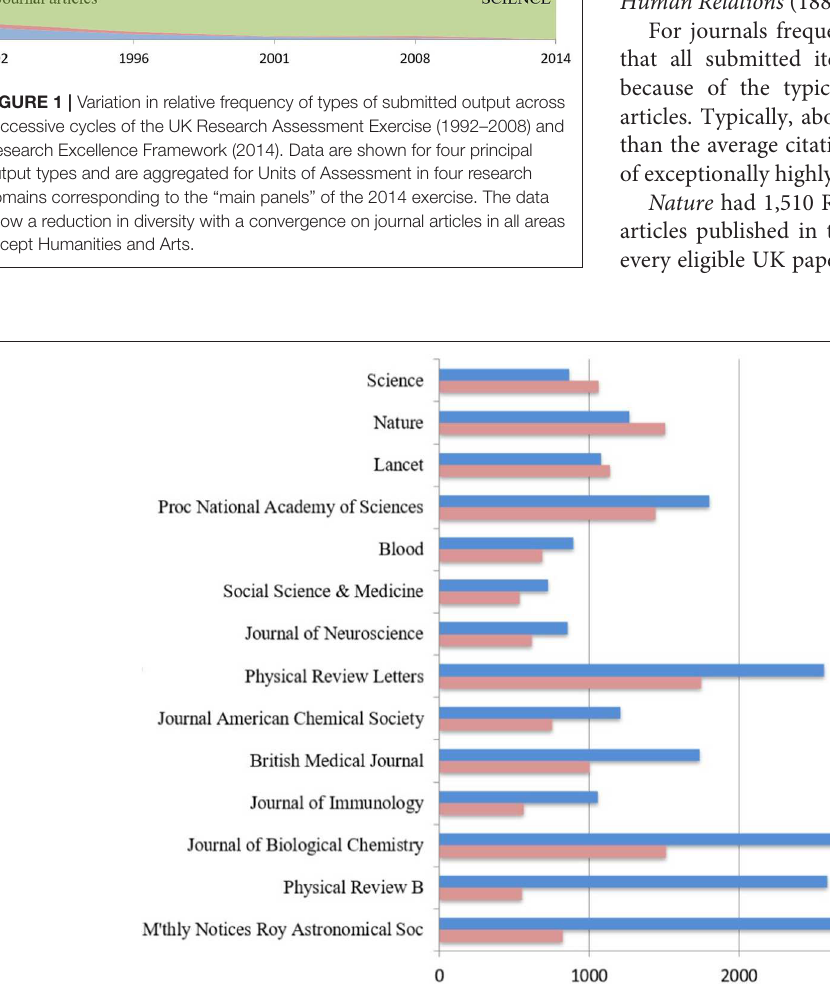
Frontiers in Research Metrics and Analytics |